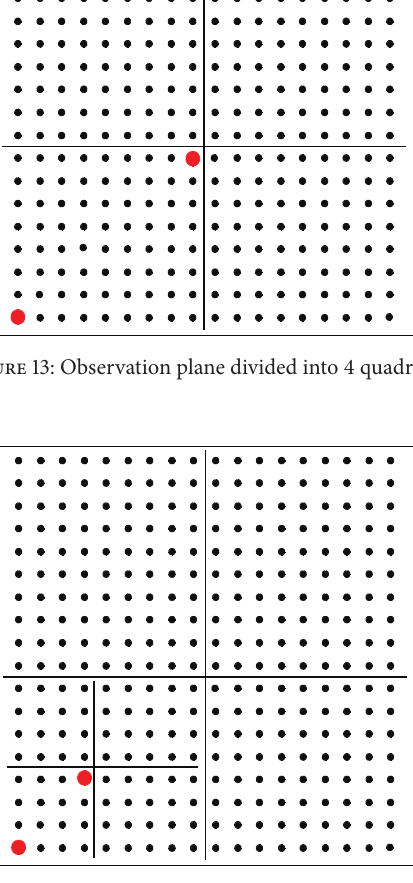
Figure 14: Division process.